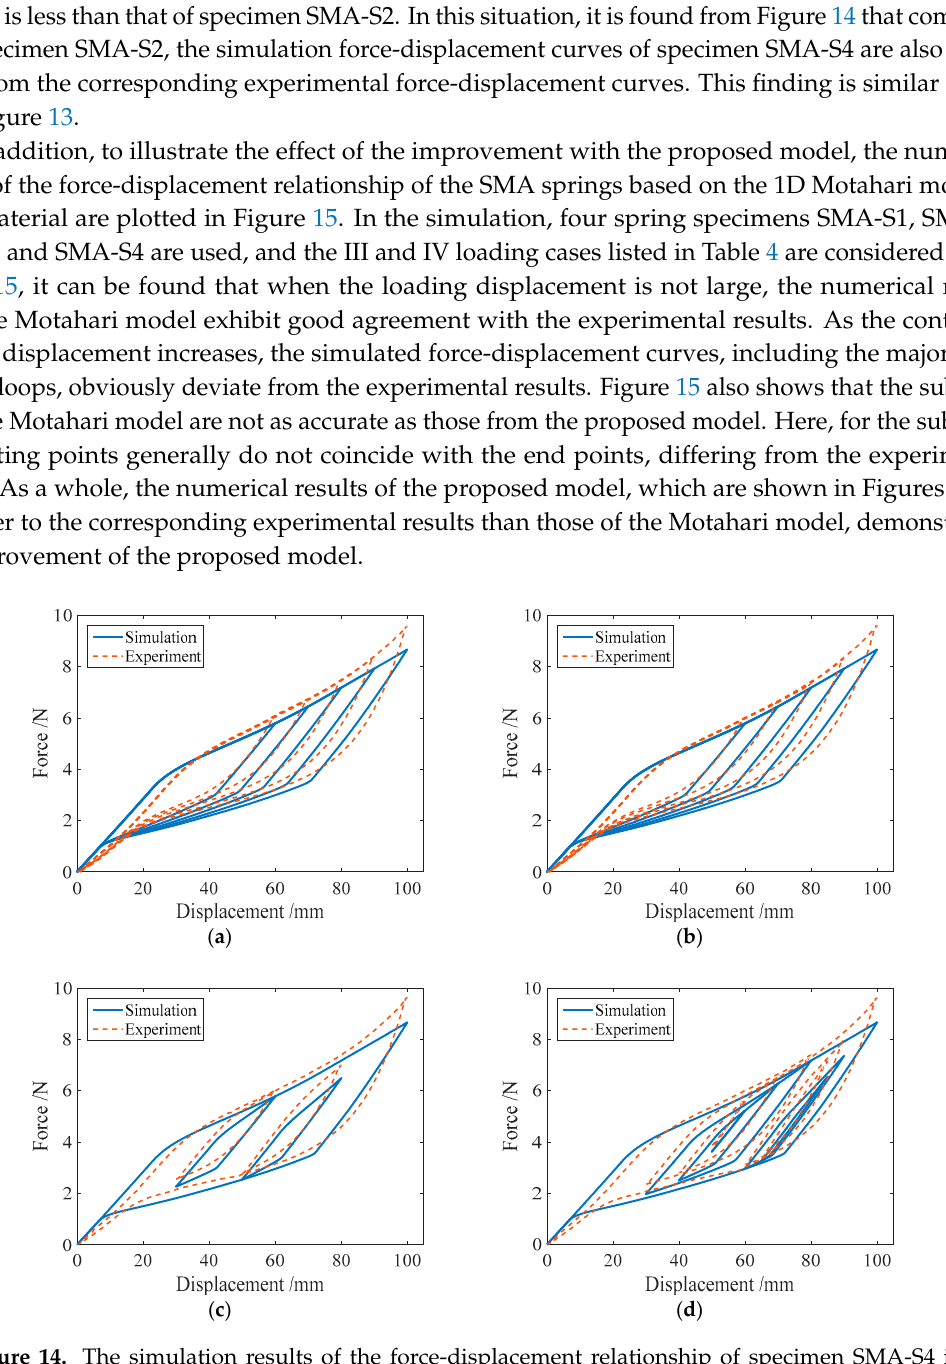
Figure 14. The simulation results of the force-displacement relationship of specimen SMA-S4 in different loading cases: ( a ) Case I; ( b ) Case II; ( c ) Case III; ( d ) Case IV.